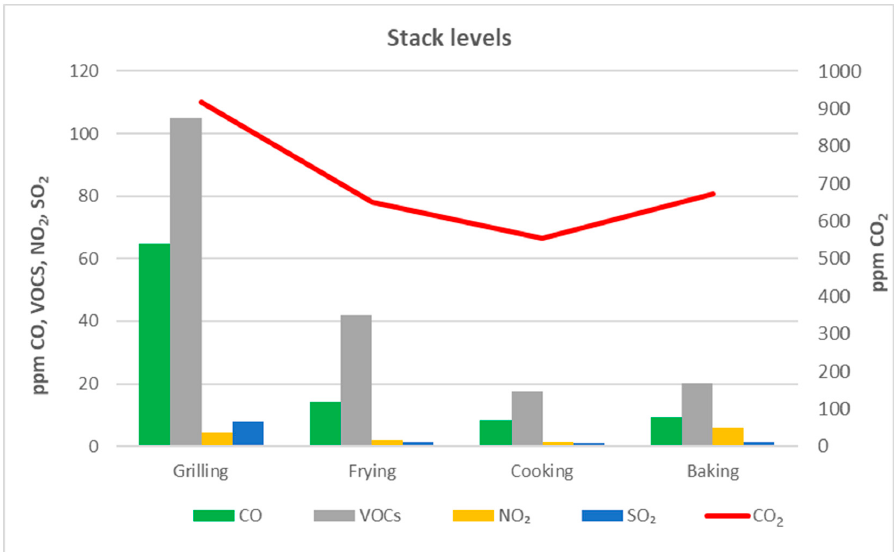
Figure 2. Mean levels of air pollutants in different restaurant chimneys.